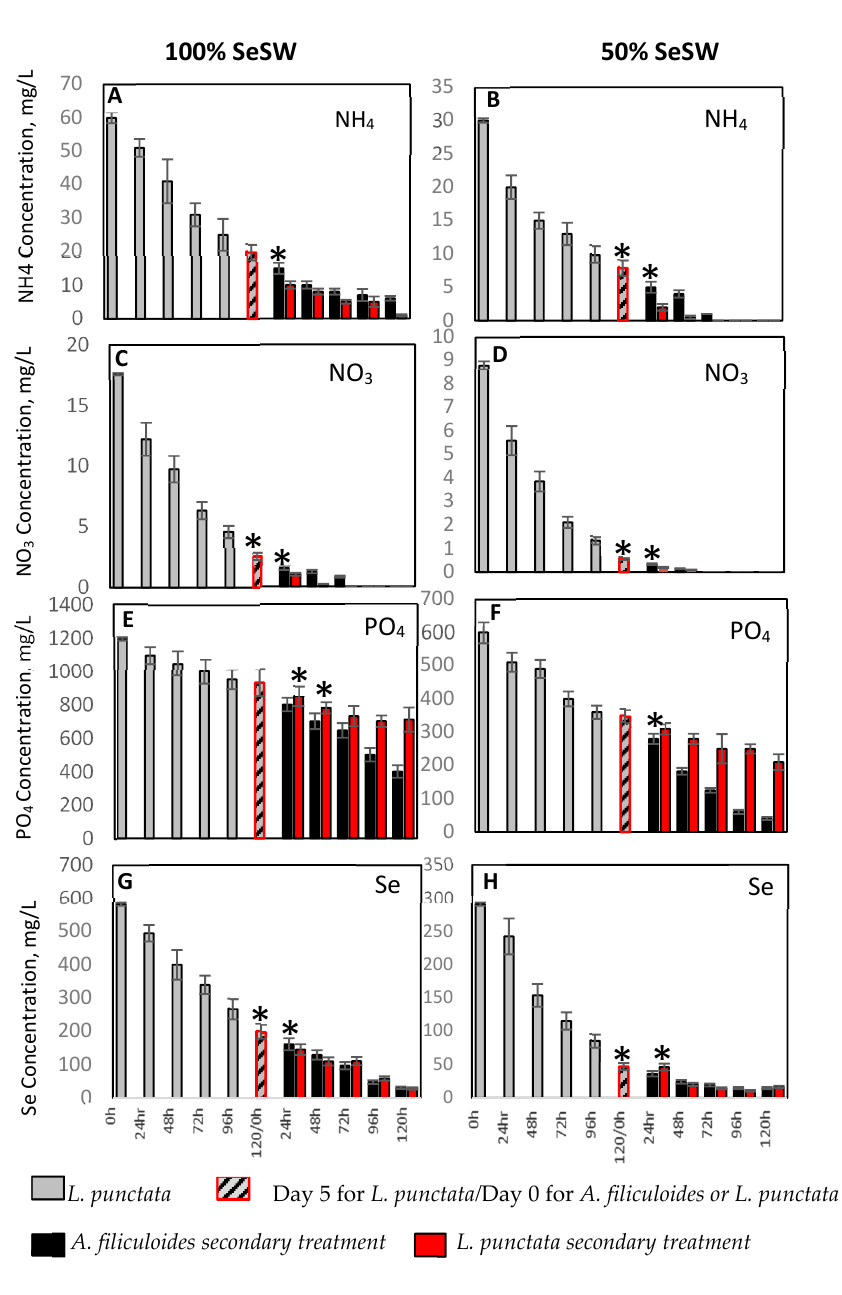
Figure 1. Reductions of concentrations of PO 4 , NH 4 , NO 3 and Se in 100% ( A , C , E , G ) and 50% ( B , D , F , H ) SeSW by L. punctata followed by sequential treatment with A. filiculoides or L. punctata . Data expressed as mean ± standard deviation, * Significance levels: p <